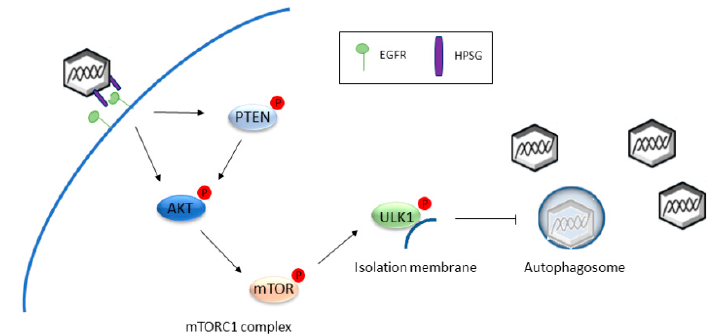
Figure 1. HPV16 binding and internalization inhibits autophagosome formation. HPV virions decorated with HPSGs interact with EGFRs present on the plasma membrane of target cells, resulting in Akt and PTEN phosphorylation, and in phosphorylation and activation of mTOR. Activated mTOR phosphorylates and inactivates ULK1, present on isolation membranes, inhibiting autophagosome nucleation and, therefore, delays L1 digestion and capsid degradation inside autophagosomes. Arrows indicate activating pathways; T-bar indicates inhibitory pathway; blue lines represent cellular and isolation membranes.